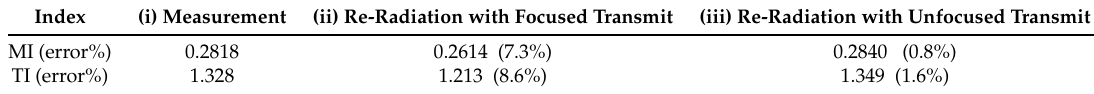
Table 2. Calculation of MI and TI based on measured and calculated pressure